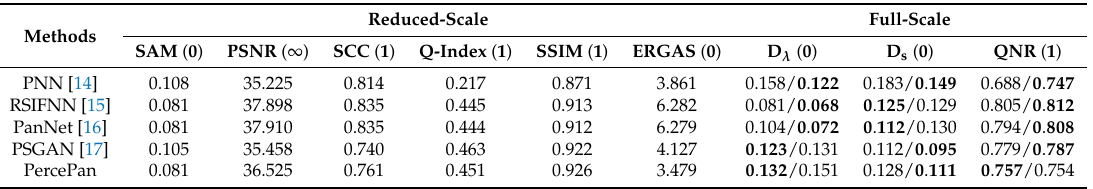
Table 6. Quality assessment of different methods under supervised/unsupervised manner on the QuickBird dataset. The best value of each index is shown in parentheses.